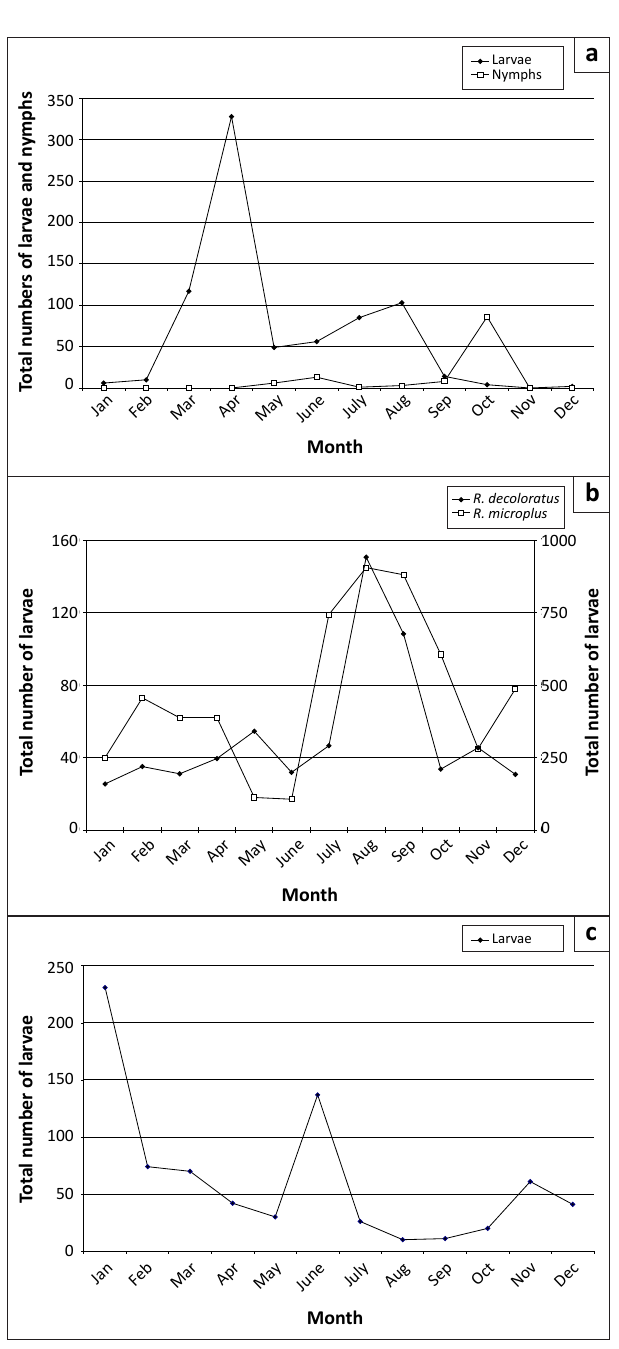
FIGURE 2: Composite seasonal abundance of questing (a) Rhipicephalus appendiculatus larvae and nymphs, (b) Rhipicephalus decoloratus and Rhipicephalus microplus larvae, and (c) Rhipicephalus evertsi evertsi larvae on the pastures at Döhne and Campagna